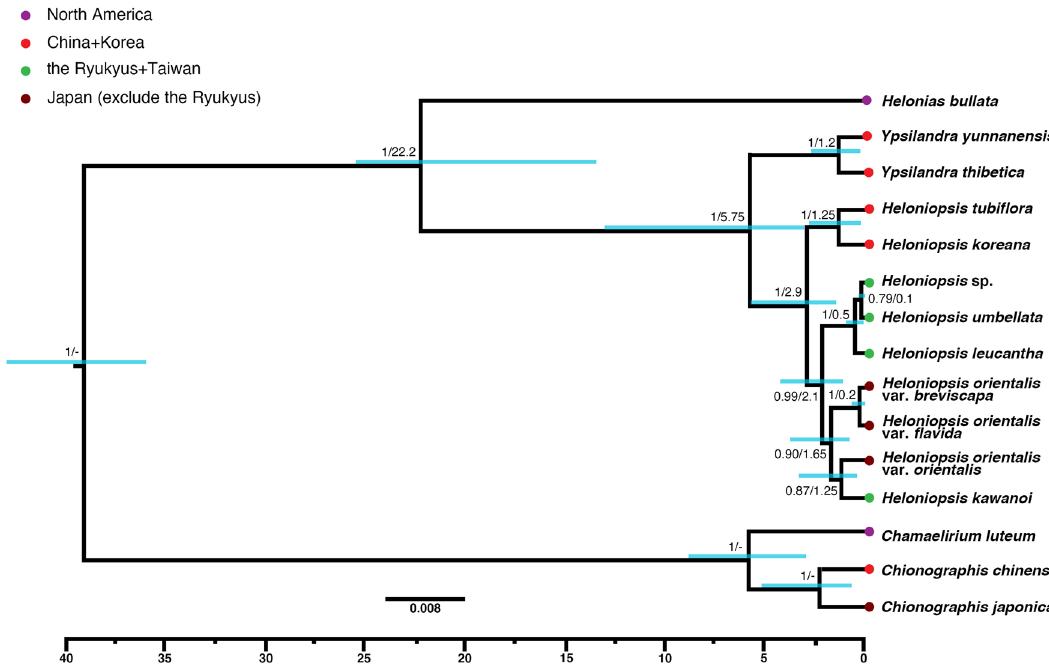
Figure 1. Phylogenetic tree of Heloniadeae reconstructed by chloroplast sequences. The value of each node represented supporting value (pp)/dating (mya), dating of outgroups not shown here. Bar on each node represent 95% HPD of dating results.